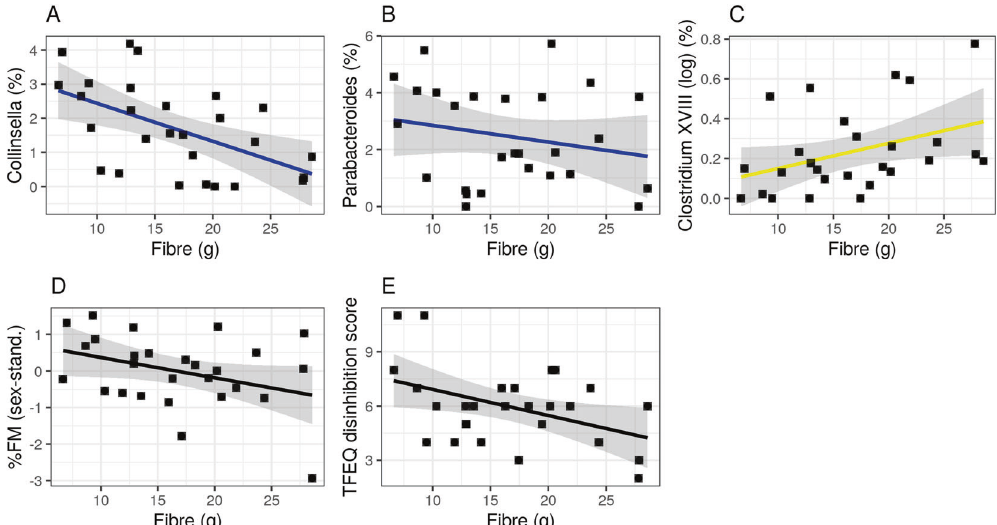
Fig. 3 Habitual dietary fi ber intake is associated with bacterial genera, body fat mass and eating traits. Pearson ’ s correlations shown for inversely health-related genera (blue) ( A , B ), health-related genera (yellow) ( C ), body fat mass (black) ( D ), and eating trait disinhibition (TFEQ) (black) ( E ) (Pearson ’ s correlation all 0.75 < | r | > 0.58, all p-FDR < 0.05; sample 1 n =